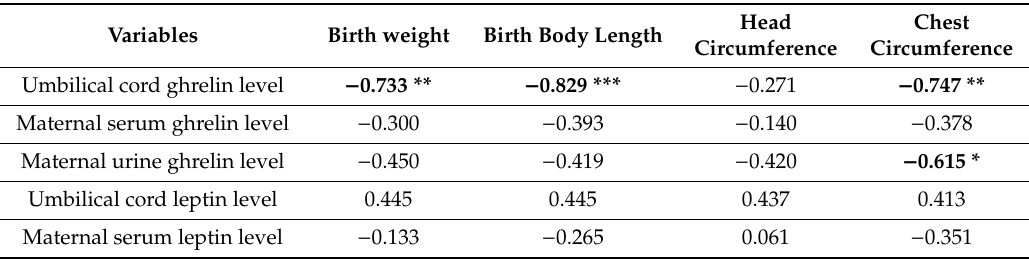
Table 3. Correlations of neonatal anthropometric measurements in the EGWG group in male subjects (Spearman’s rho coe ffi cient).